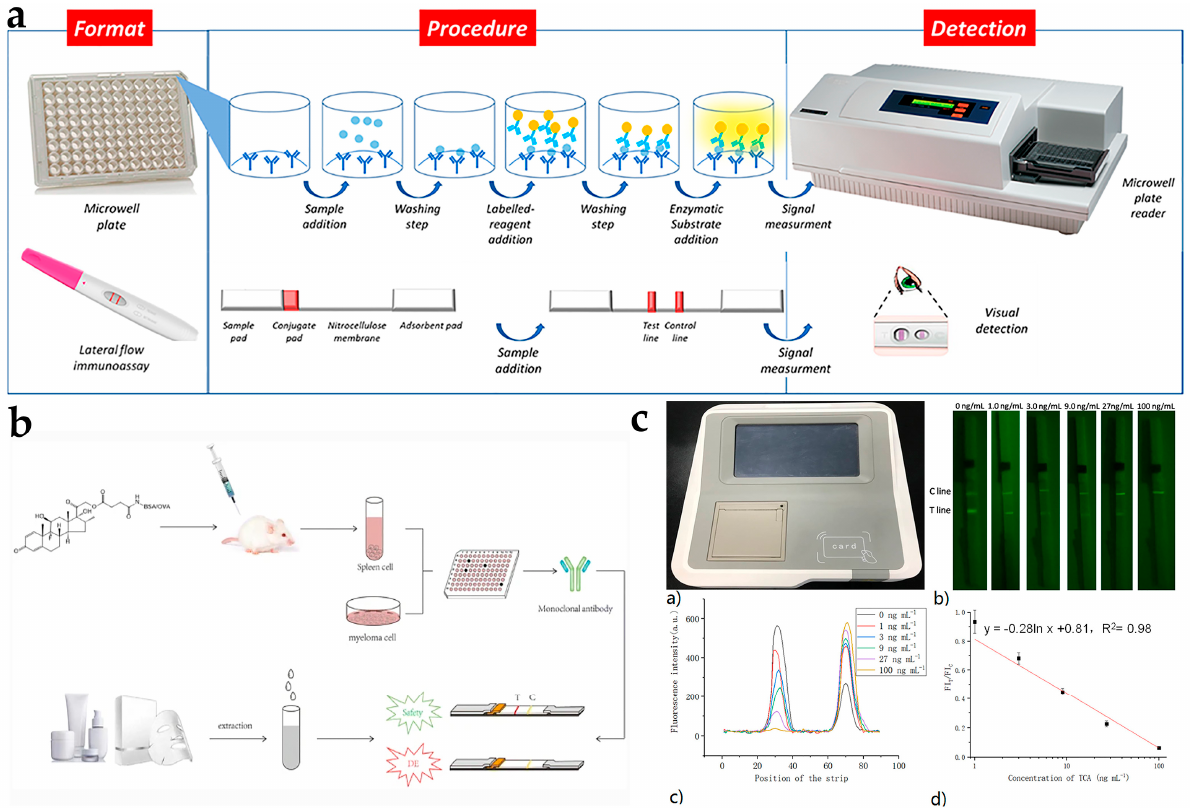
Figure 5. ( a ) Scheme of the conventional immunoassay format approaches and the LFIA principle for on-site applications. Reprinted with permission from Ref. [25] Copyright 2021 Processes. ( b ) The application of a LFIA assay to rapidly test for dexamethasone in commercial facial masks. Reprinted with permission from Ref. [85] Copyright 2019 Analytical and Bioanalytical Chemistry. ( c ) The UCNPs-LFIA for triamcinolone acetonide detection. Reprinted with permission from Ref. [87] Copyright 2019 Spectrochimica Acta Part A: Molecular and Biomolecular Spectroscopy.